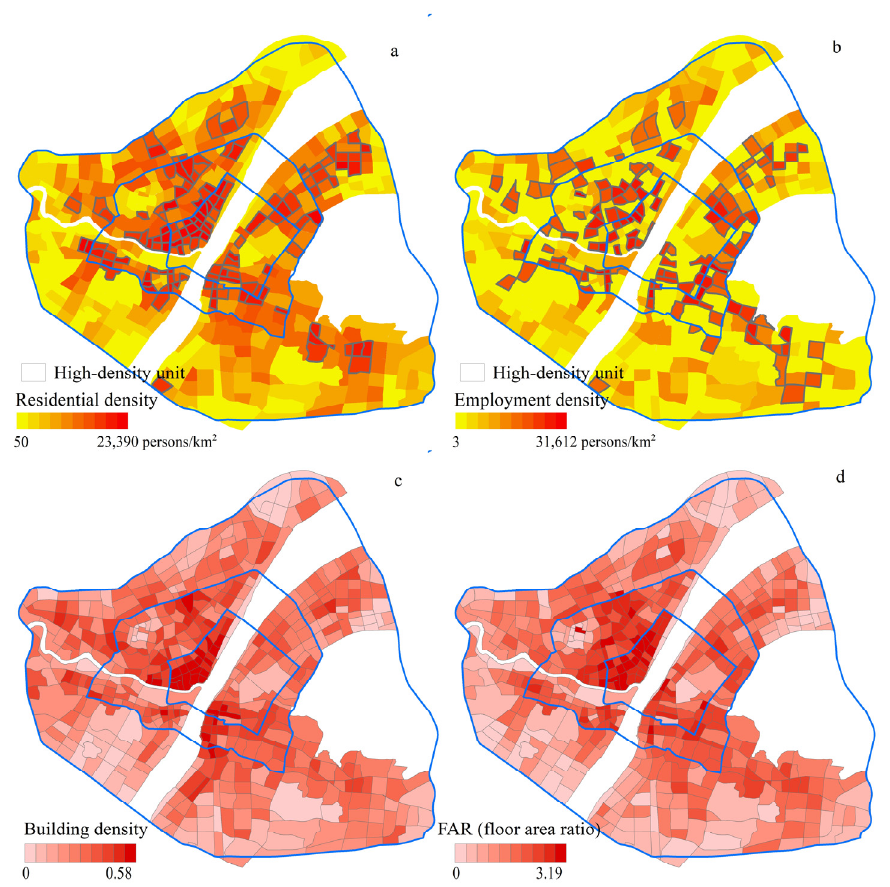
Figure 2. Population density and urban form metrics.